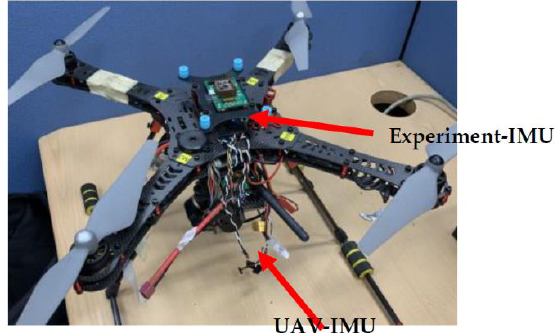
Figure 3. Experimental setup for the measurements collecting from UAV-IMU and Experiment-IMU.